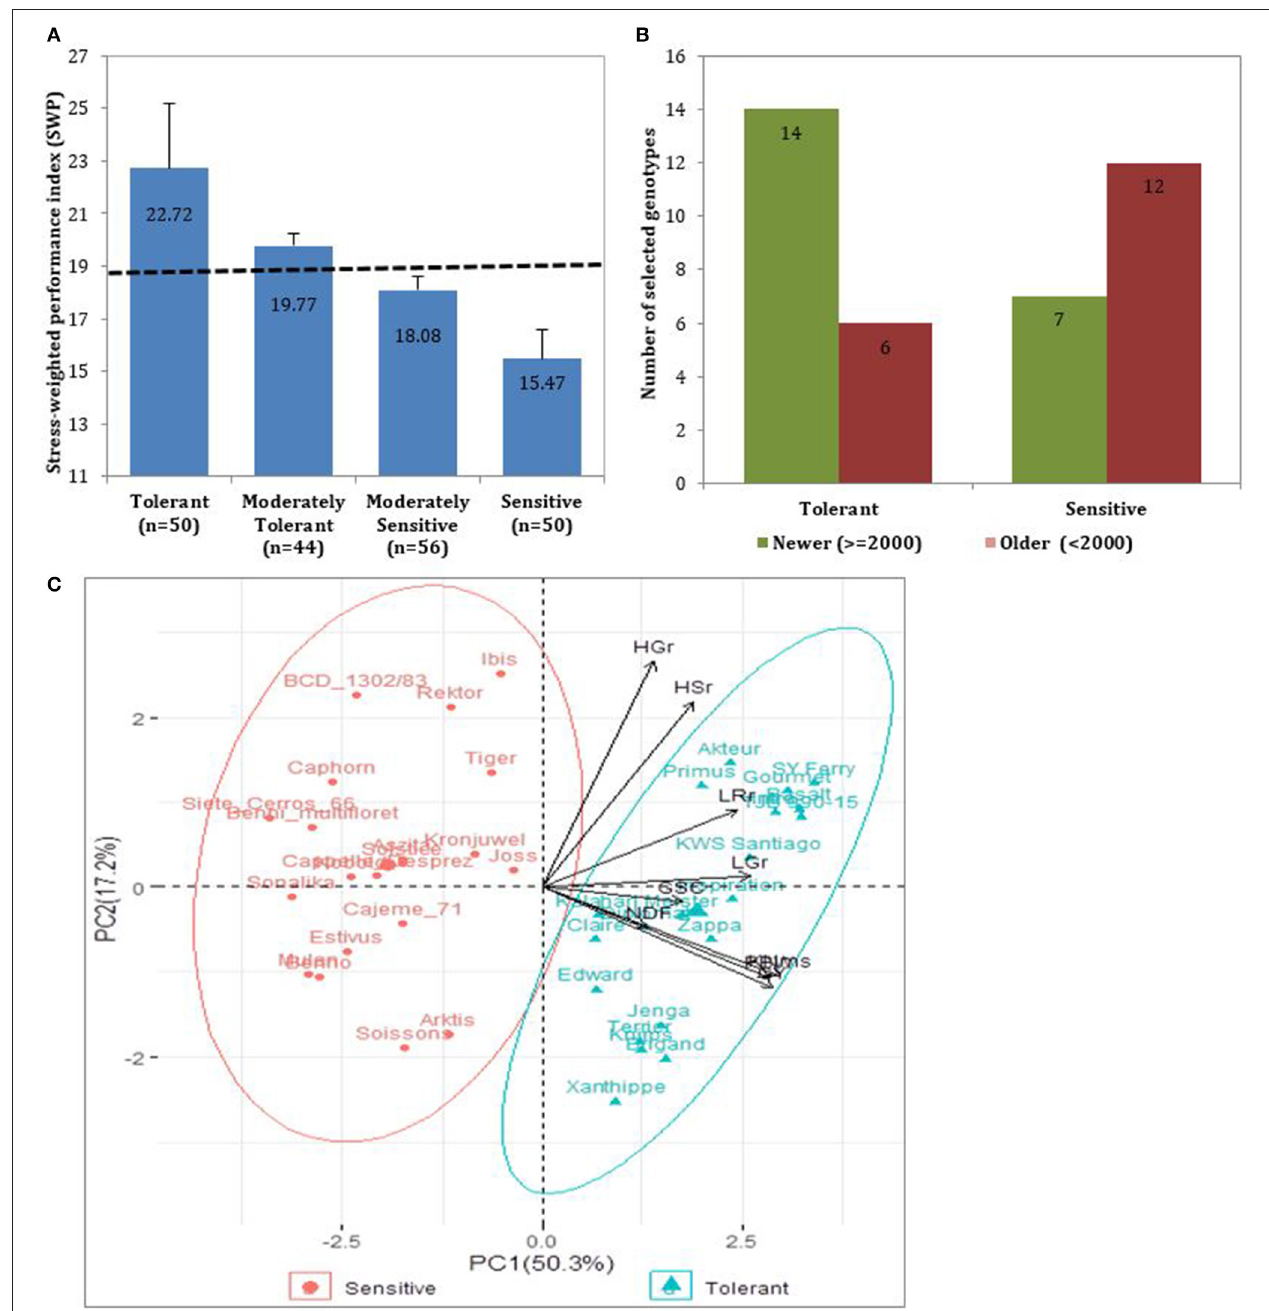
FIGURE 3 | Representation of the studied cultivars based on SWP. (A) SWP representation of all the 200 cultivars classified into four drought tolerance groups. The dotted line represents the average SWP value of the entire population (SWP 18.96). (B) The number of selected 20 drought-tolerant and 20 drought-sensitive = cultivars. Selected cultivars were classified into Newer (released in/or after 2000) or older (released before 2000). The selection was based on SWP of agronomic and grain quality traits, and the visual scores of developmental traits under drought stress conditions. (C) Scatter plot showing clustering of the tolerant (green) and sensitive (red) cultivars based on the PCA analysis of their SWP rankings of evaluated traits.